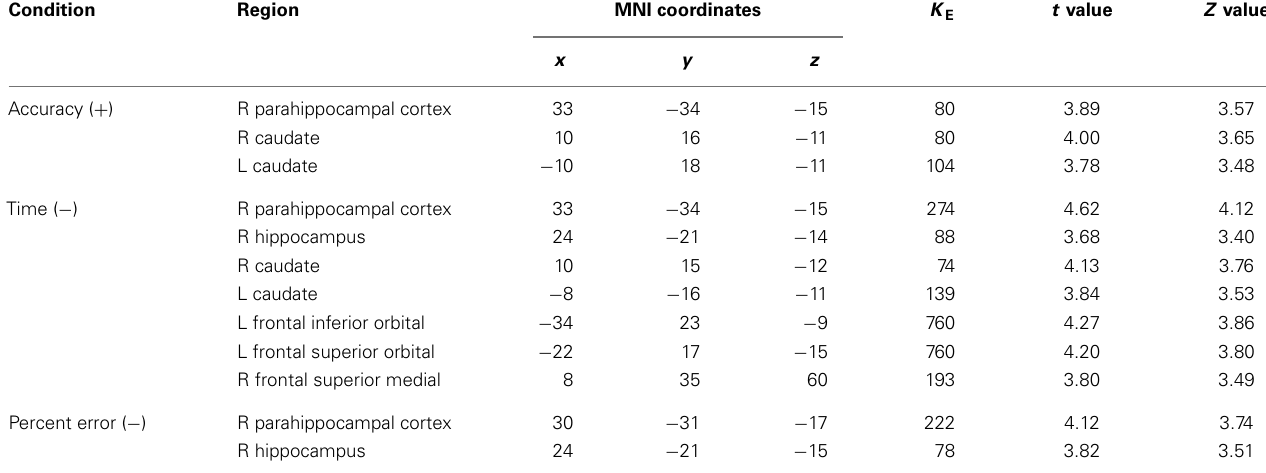
hippocampus when contrasting the control group to the patient group ( − 22, − 22, − 17). (B) GM differences in the right hippocampus when contrasting the control group to the patient group right (36, − 9, −